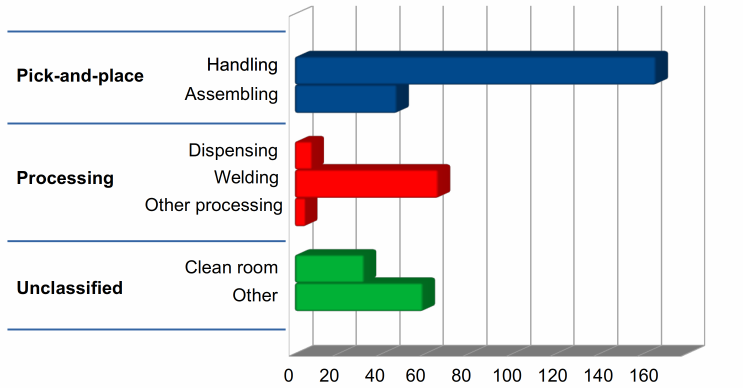
Figure 1. The annual number of newly installed robots in 2020, in thousands of pieces, broken down by categories of tasks. There are three main task categories: pick-and-place, processing and unclassified. The drawing was elaborated based on